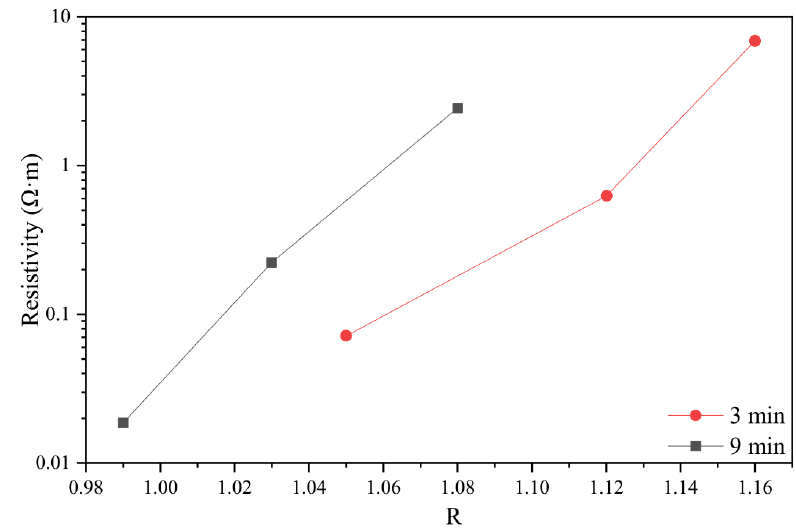
Figure 8. The effect of graphite degree on resistivity.